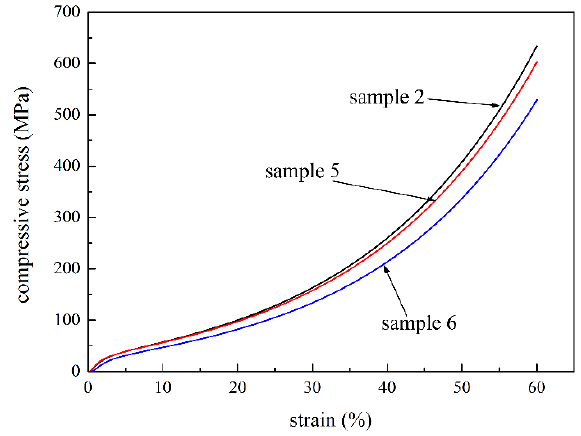
Figure 5. Compressive curves of samples 2, 5, and 6 with 75 MPa, 65 MPa and 55 MPa pressure, respectively.